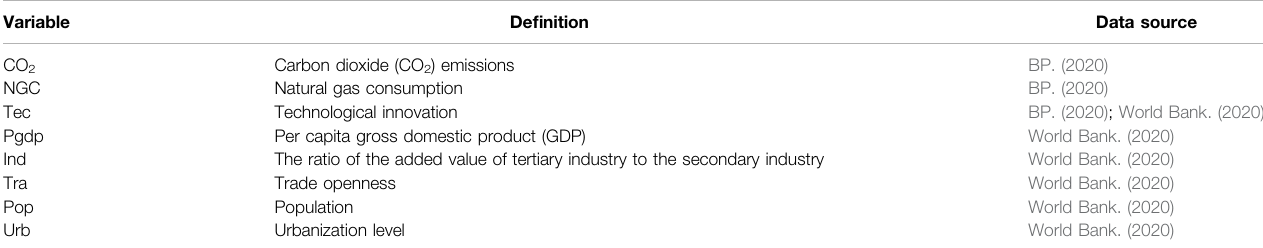
TABLE 1 | Description of all the selected variables.